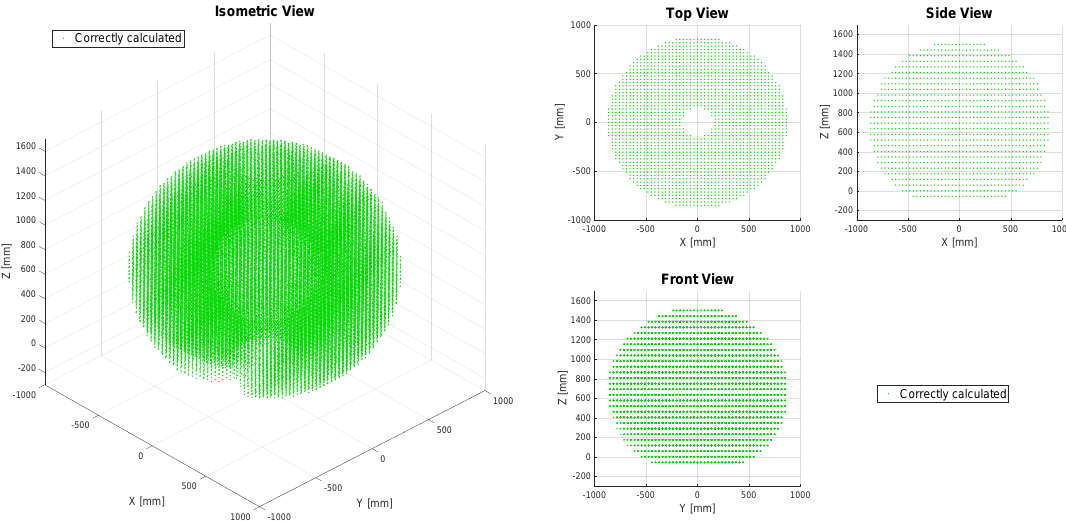
Figure 7. Performance analysis of the synthesized IKM for the PUMA 560. The left side shows the isometric view of the PUMA’s workspace, while the right side presents the top, side, and front views of the same workspace. Marked in green (“Correctly calculated”) are all the the positions in which the IKM obtains the same amount of solutions as the reference model, with an RMS error lesser than 1 × 10 − 8 . The data show that all the positions of the analyzed workspace are correctly